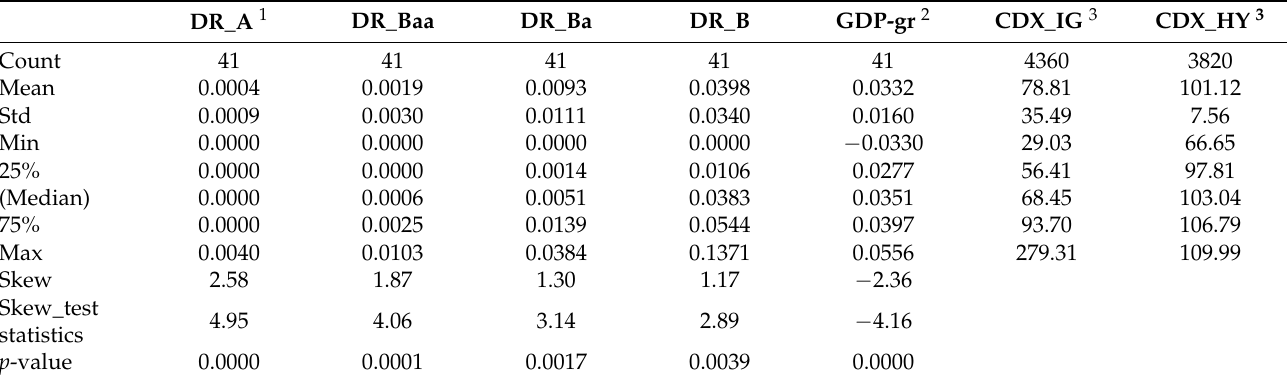
Table 1. Basic data information and descriptive